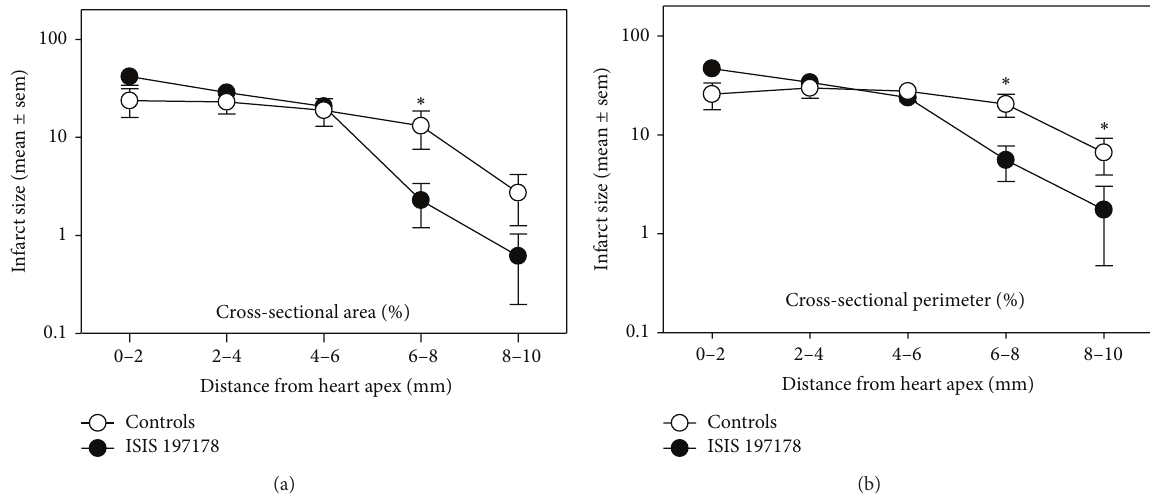
Figure 3: ASO-mediated lowering of CRP in rats subjected to coronary artery ligation reduces infarct size. For hearts from the animals shown in Figure 2, percent infarcted region (area (a) or perimeter (b)) was calculated from picrosirius red-stained LV sections (see Materials and Methods). Rats were injected i.p. with either 0.9% saline or ASO 141923 at 150 mg/kg/wk) (controls, 𝑛 = 9 ), or an equivalent dose of the CRP targeting ASO ISIS 197178 (𝑛 = 12) . The asterisks indicate ∗ 𝑃 < 0.05 for unpaired t -tests.